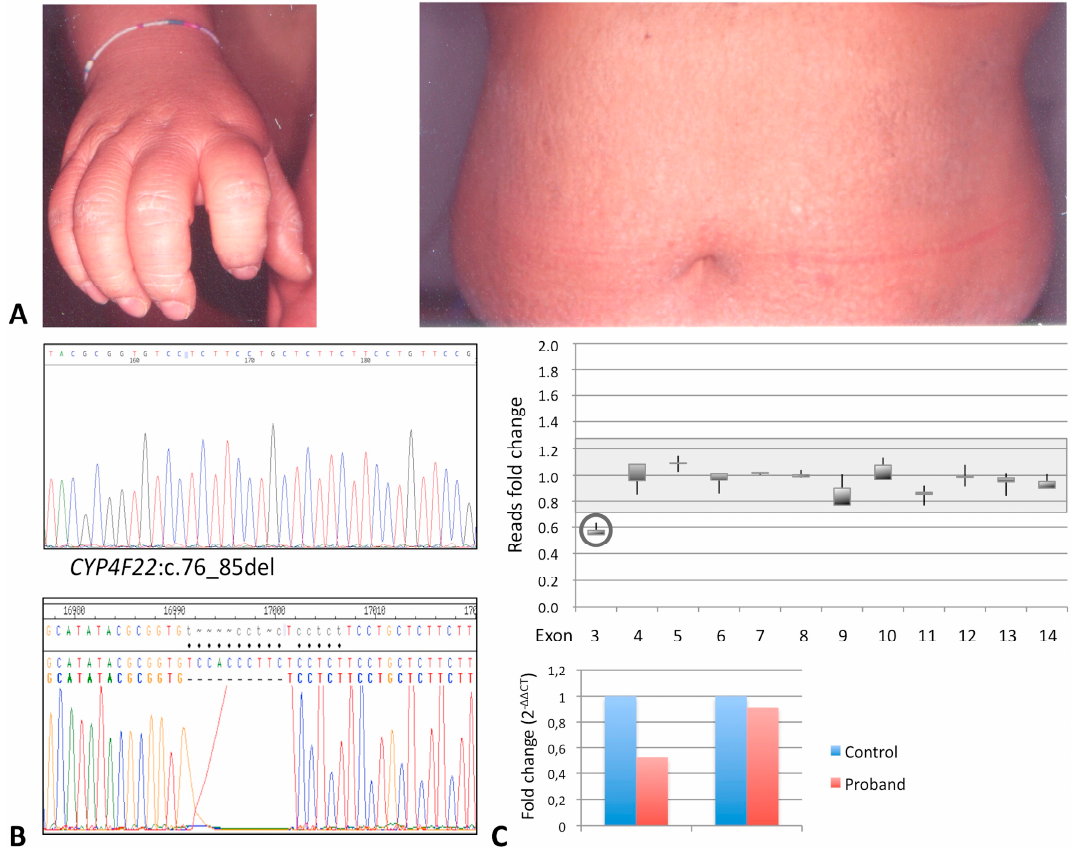
Figure 4. Phenotypic and genetic features of patient 4. ( A ) Marked hand hyperkeratosis and white-grey scaling with diffused erythroderma on the trunk are shown. ( B ) Screenshots of the sequence electropherogram (top panel) and of its graphical assembly with the normal gene sequence (bottom panel) show the ten-nucleotide deletion leading to the putative frameshift variant p.Thr26Serfs* in CYP4F22 . ( C ) Gene dosage obtained in the patient by evaluating the read depth for each of the 12 CYP4F22 coding exons (starting ATG within exon 3) normalized to the median read depth of all the exons of an autosomal gene ( AGRN ) (see Materials and Methods) and represented as fold change with respect to three normal controls (top graph). Real-time qPCR analysis of CYP4F22 exon 3 in the proband; signal quantification is normalized to an autosomal gene sequence and represented as fold change with respect to a normal control (2 − ΔΔ Ct method) (bottom graph).